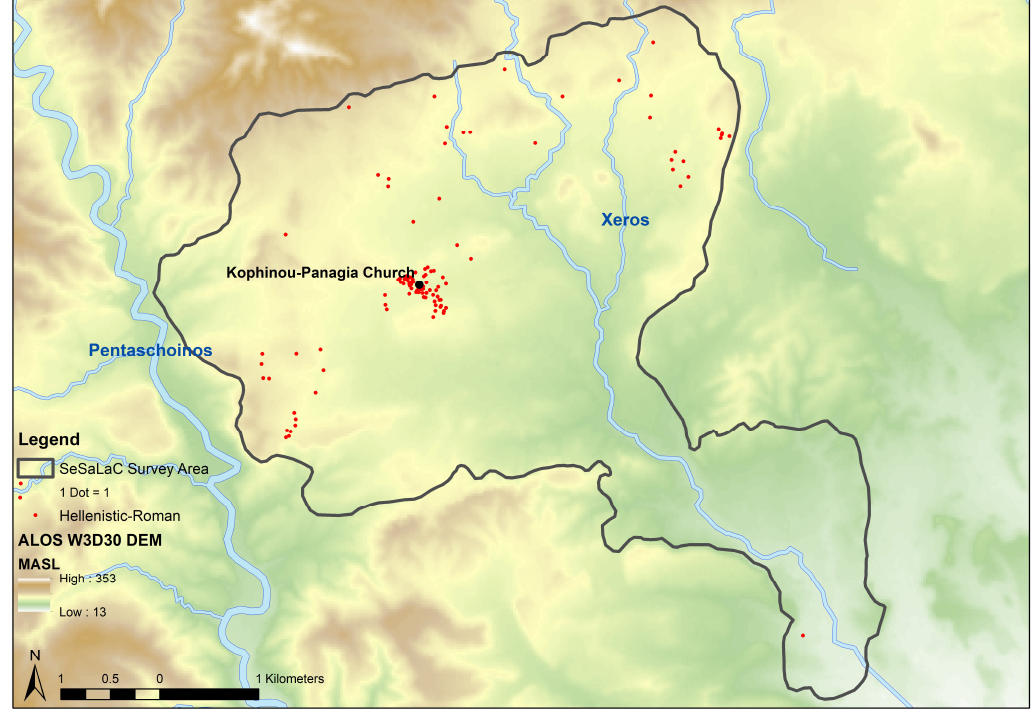
Figure 21. Hellenistic and Roman pottery distribution. ALOS DEM are in metres. Digital data courtesy of the Geological Survey Department, Republic of Cyprus (Map by Charalambos